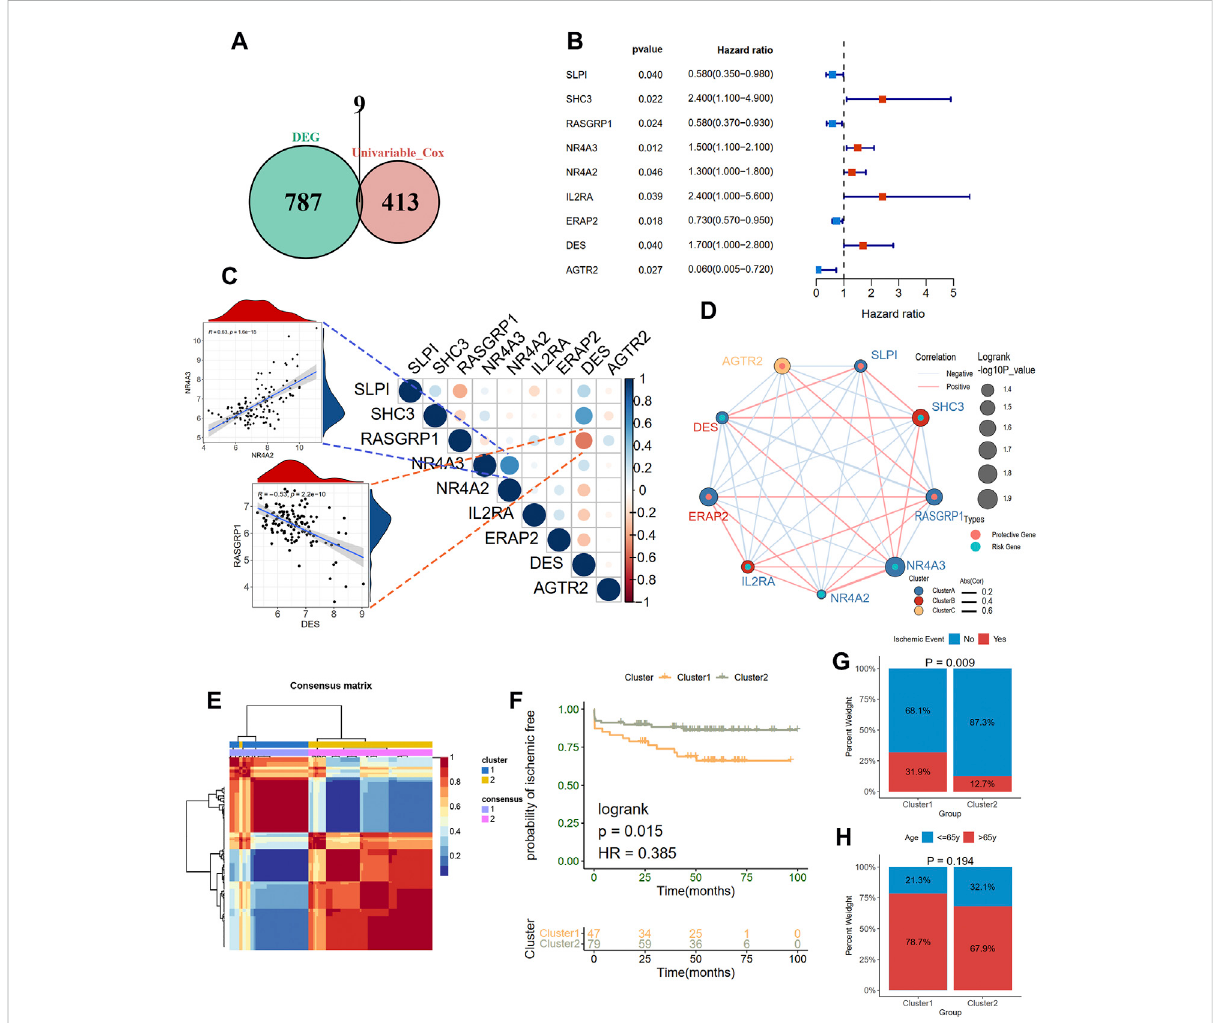
FIGURE 3 Clustering two molecular subgroups through nonnegative matrix factorization (NMF) method. (A) Screening nine prognostic DEIRGs by overlapping the DEIRGs and prognostic genes with univariate Cox regression analysis. (B) A forest plot showing the hazard ratio of nine prognostic DEIRGs. (C) and (D) indicating the expression correlations of the nine prognostic DEIRGs. The enlarged panels show the most positive and negative correlation. (E) Identi fi cation of two clusters with the optimal value for consensus clustering. (F) Survive analysis of two distinct clusters. A histogram shows the proportion of the occurrence of an ischemic event (G) and age group (H) in two